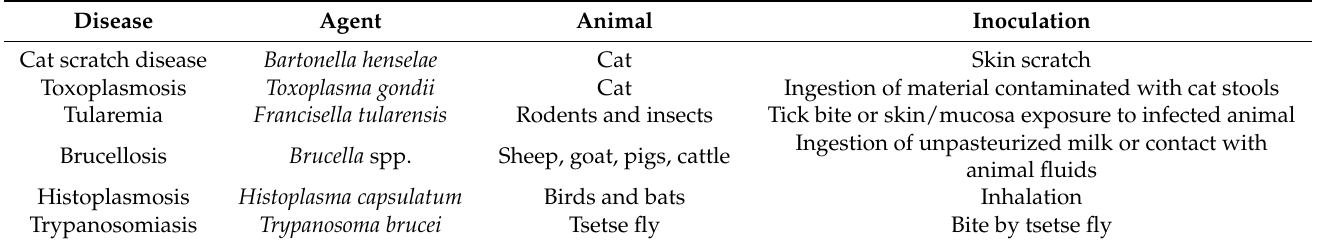
Table 1. Main zoonosis associated with acute lymphadenitis in pediatric